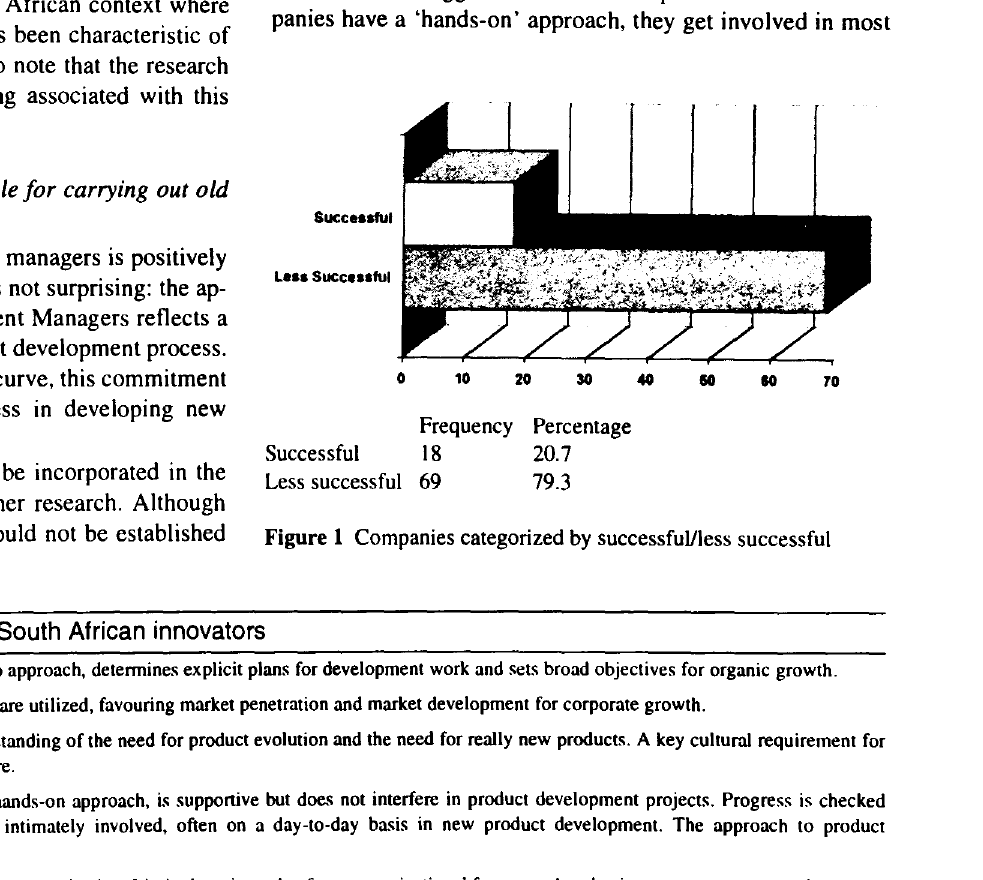
Table 6 Characteristics of leading South African innovators Strategy Shared